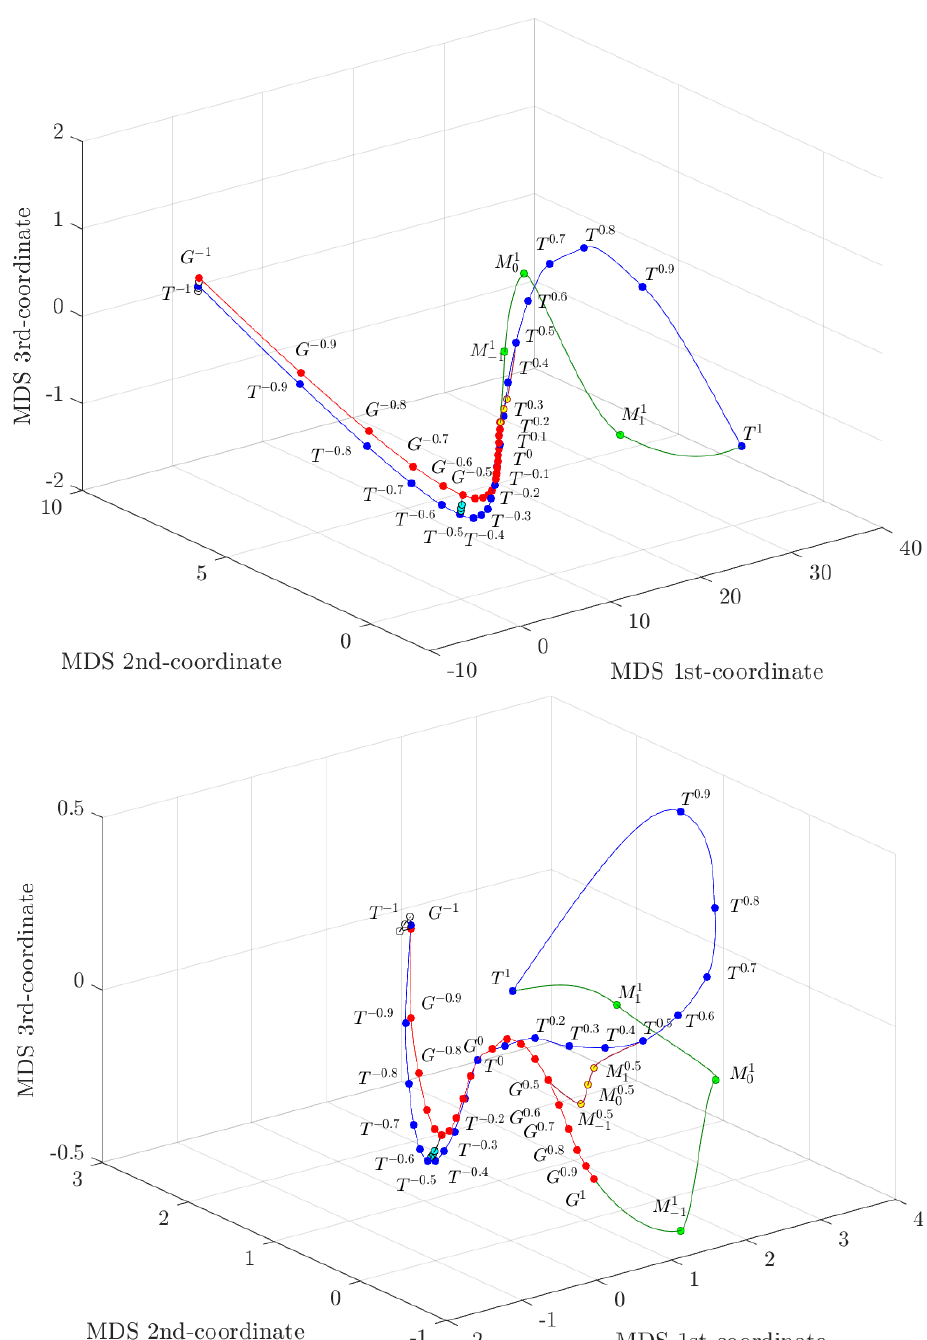
Figure 6. MDS loci of the N = 54 numerical series produced by the Euclidean ( top ) and Tchebychev ( bottom ) distances, d Tc and d Ac , for r =